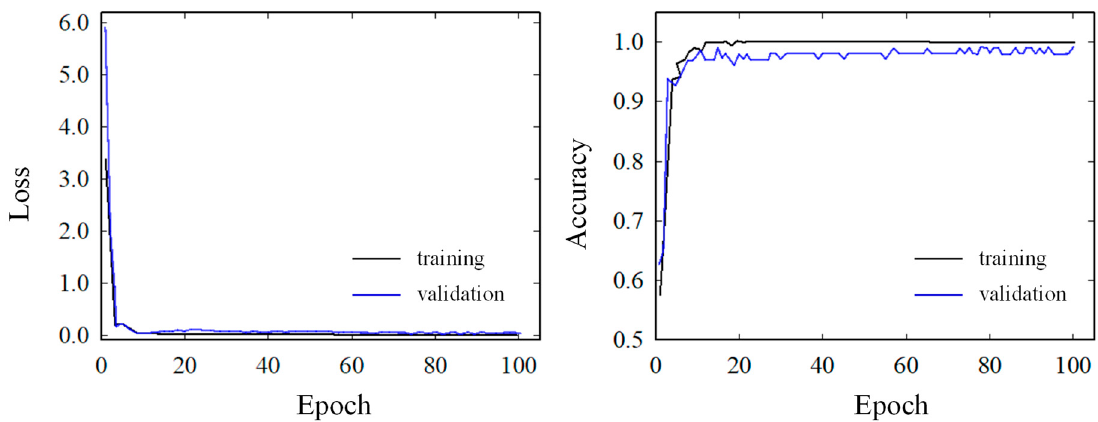
Figure 5. Accuracy according to epoch.